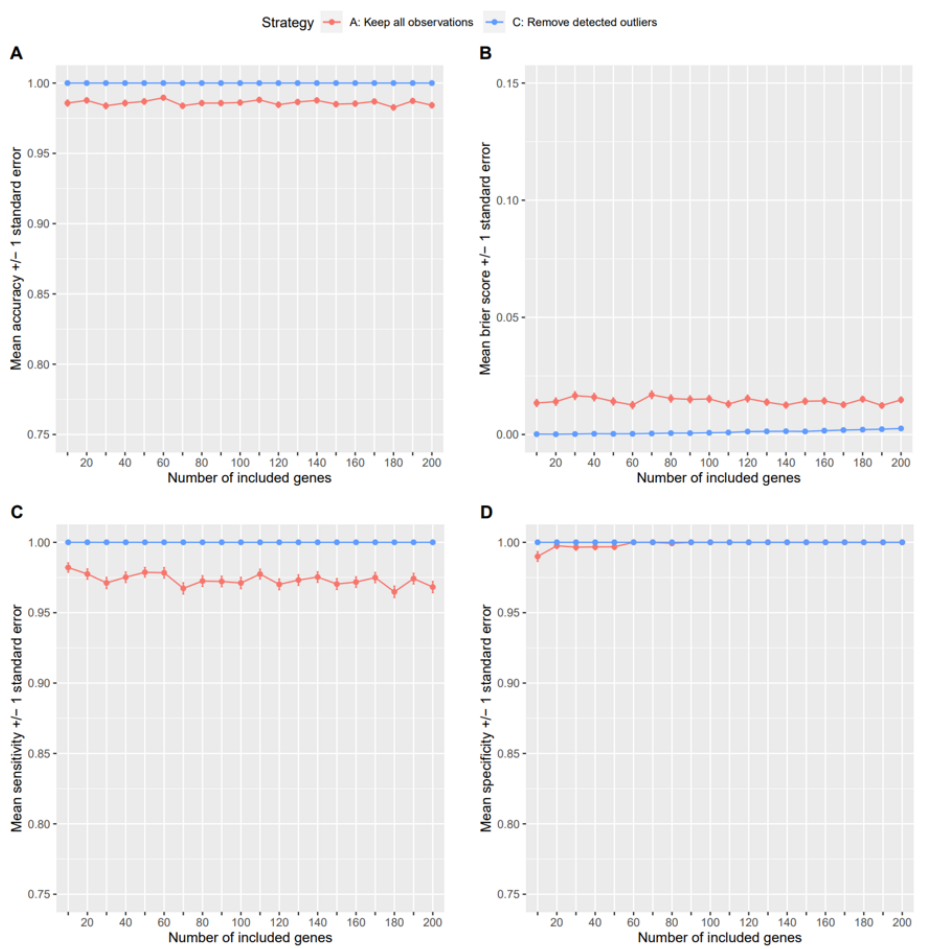
Figure 8. Performances for different outlier handling strategies for the WNV dataset. The figure shows mean values with error bars representing standard errors for accuracies ( A ), Brier scores ( B ), sensitivities ( C ), and specificities ( D ), respectively, when using a SVM for classification and for different numbers of most differentially expressed genes to be included in the